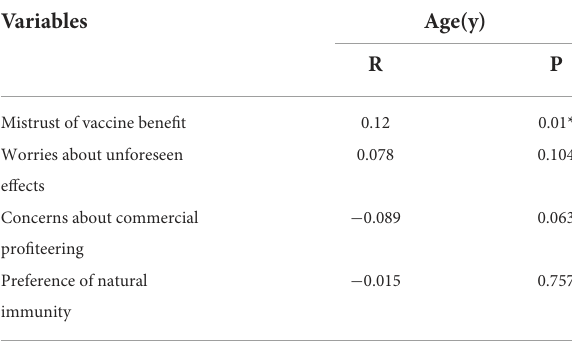
TABLE 6 Correlation between age and attitude toward COVID-19